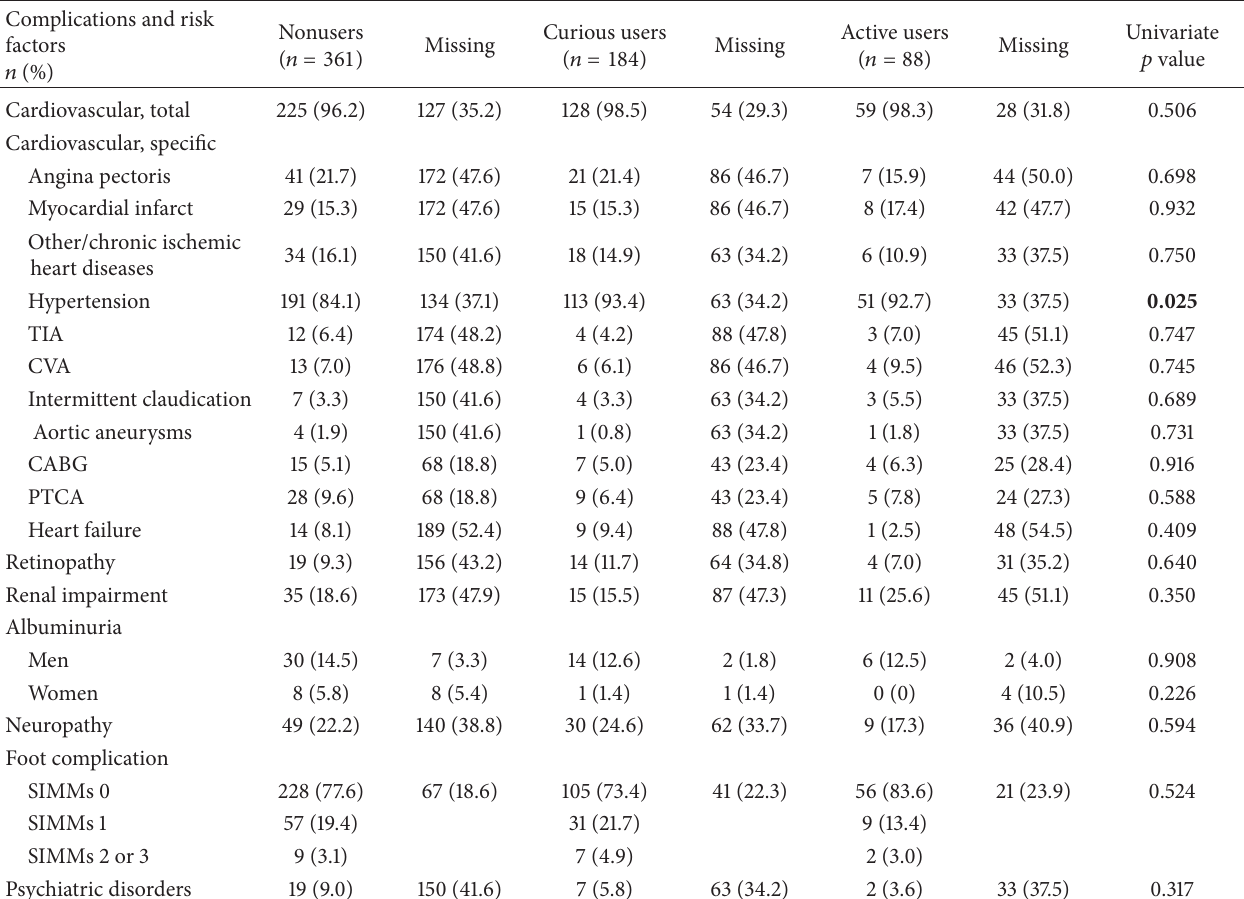
Table 11: Complications and risk factors of curious users, active users, and